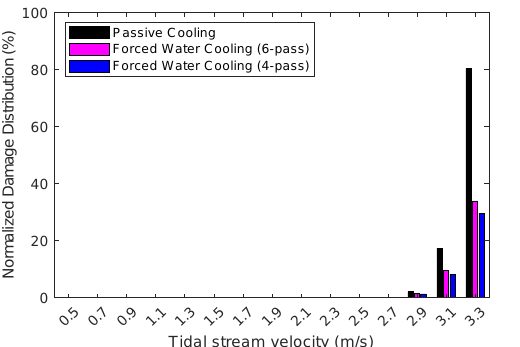
Figure 20. Annual damage distribution between different cooling systems as a function of tidal stream velocity. The values are normalized with respect to annual damage in passively cooled systems. Lifetime consumption mostly happens at higher tidal